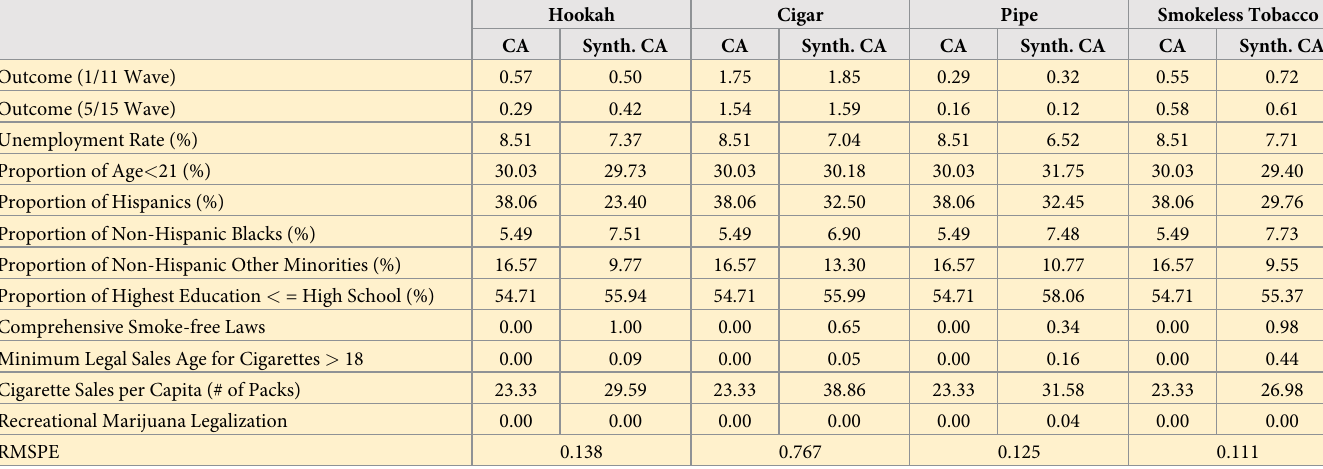
Table 2. Descriptive statistics of predictor variables in California and synthetic control: Non-cigarette use outcomes–current use.